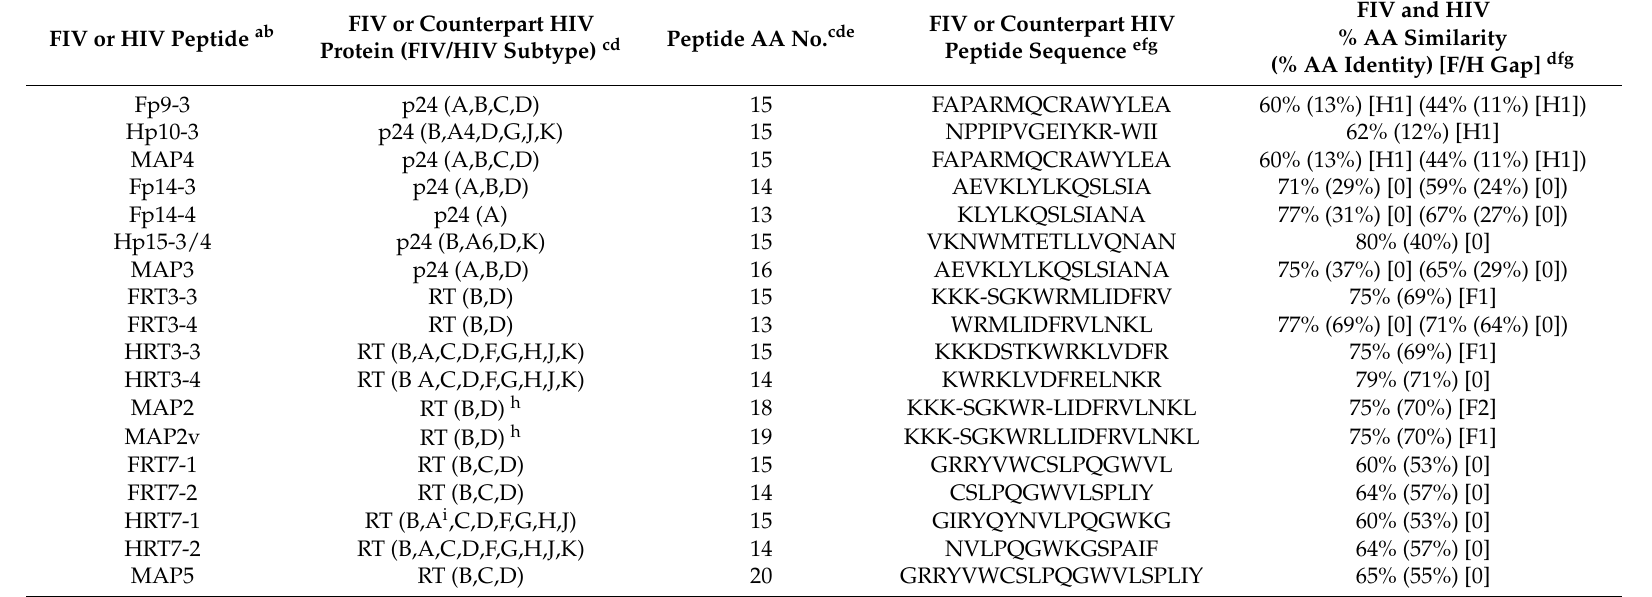
Table 1. Sequence conservation between the protective FIV peptides and their counterpart HIV-1 (HIV) peptides. FIV or Counterpart HIV FIV or Counterpart HIV FIV or HIV Peptide ab Peptide AA No. cde Protein (FIV/HIV Subtype) cd Peptide Sequence